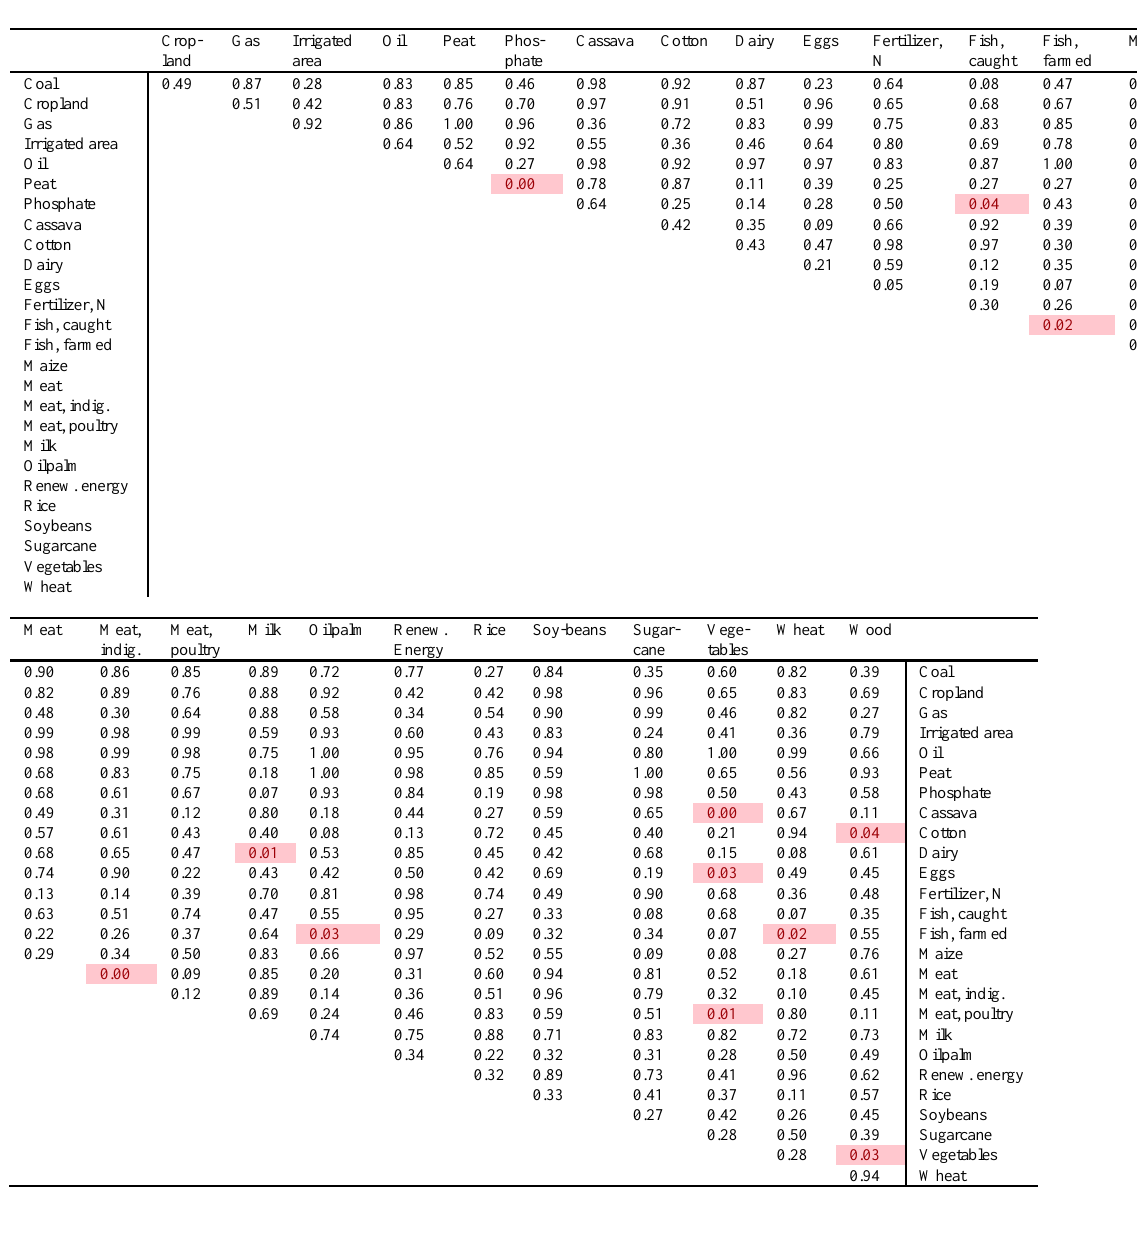
Table A1.2. P values of Haugh test of independence between pairs of time series. This table allows the selection of time series which are statistically independent. Looking vertically and horizontally, pairs of time series which are significantly dependent are in red. By keeping only one of the two time series in the pair which is significantly dependent, a set of independent resources is selected. Specifically, failing to reject ( P >0.05) the two-sided null hypothesis of independence between time series imply that both resources can be used in peak-rate analyses. Highlighted numbers represent statistically significant dependence between the two time series at a Type I error rate of 0.05, so that one of the two time series is excluded. As a result, peat, phosphate, fish farmed, indigenous meat, dairy, vegetables and cotton are not included in the hypothesis test of synchrony. The remaining time series represent a set of statistically independent